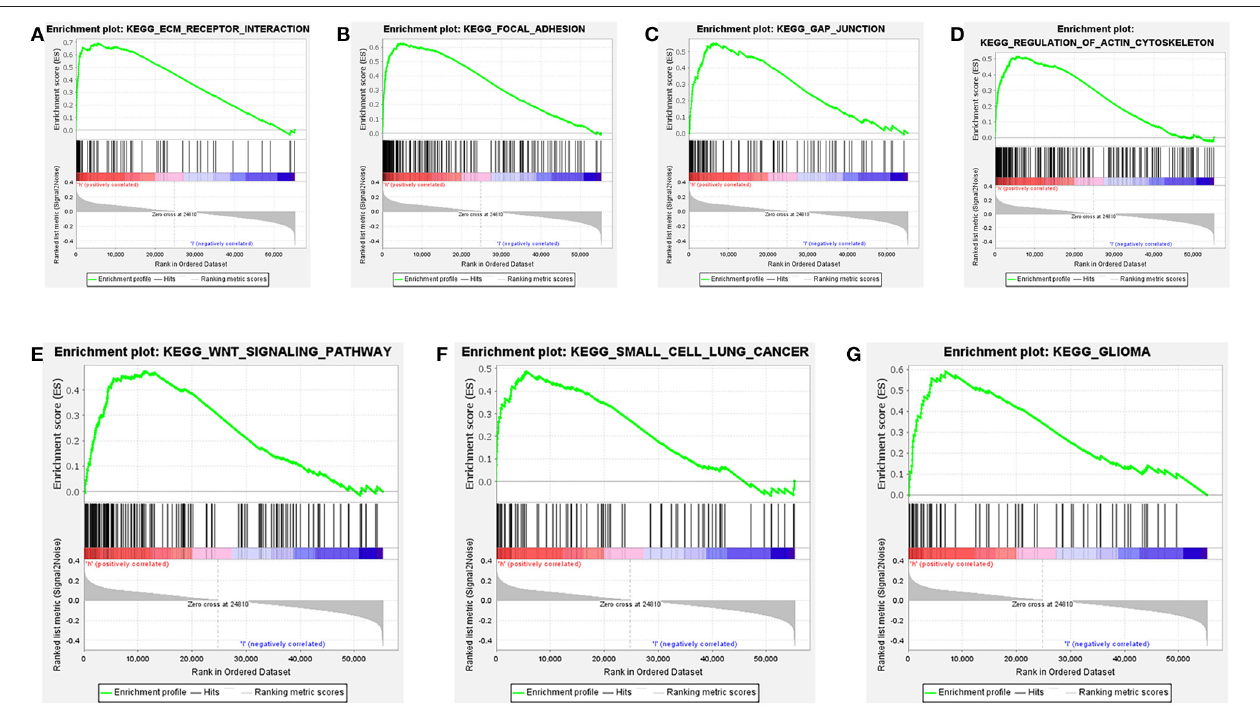
FIGURE 9 | Gene set enrichment analysis (GSEA) based on TCGA data set shows that cancer-related pathways are significantly enriched in highly expressed populations. (A) extracellular matrix (ECM) receptor interaction, (B) focal adhesion, (C) gap junction, (D) regulation of actin cytoskeleton, (E) wnt signaling pathway, (F) small cell lung cancer, (G) glioma. The highly expressed population is significantly enriched in ECM receptor interaction, focal adhesion, gap junction, and the regulation of the actin cytoskeleton